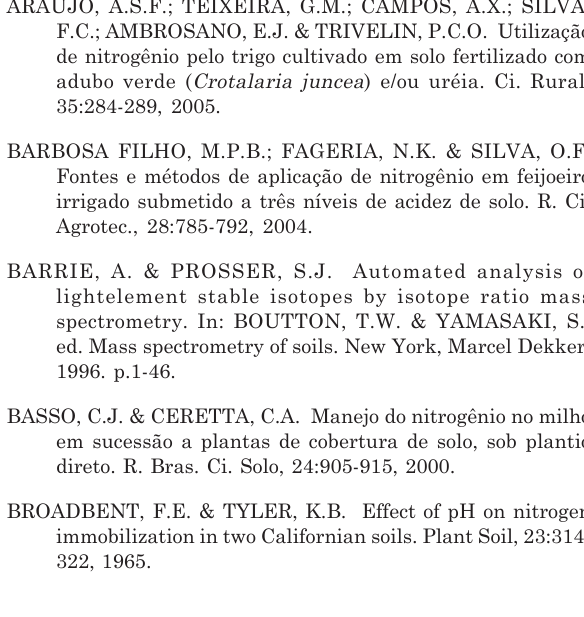
Figura 8. Produtividade de grãos após a aplicação em pré-semeadura e cobertura das fontes sulfato de amônio (SA) e uréia (U), na cultura de milho em sistema plantio direto. Médias seguidas de letras maiúsculas iguais entre épocas de aplicação não diferem significativamente pelo teste de Tukey a 0,05 %. Médias seguidas de letras minúsculas desiguais entre fontes diferem significativamente pelo teste de Tukey a 0,05 %.